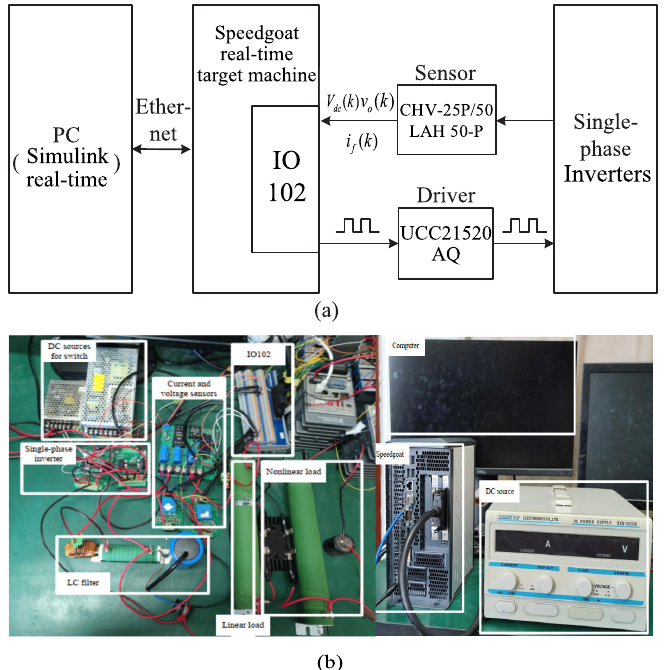
Figure 8. Experimental test bench: ( a ) block diagram, ( b ) experimental